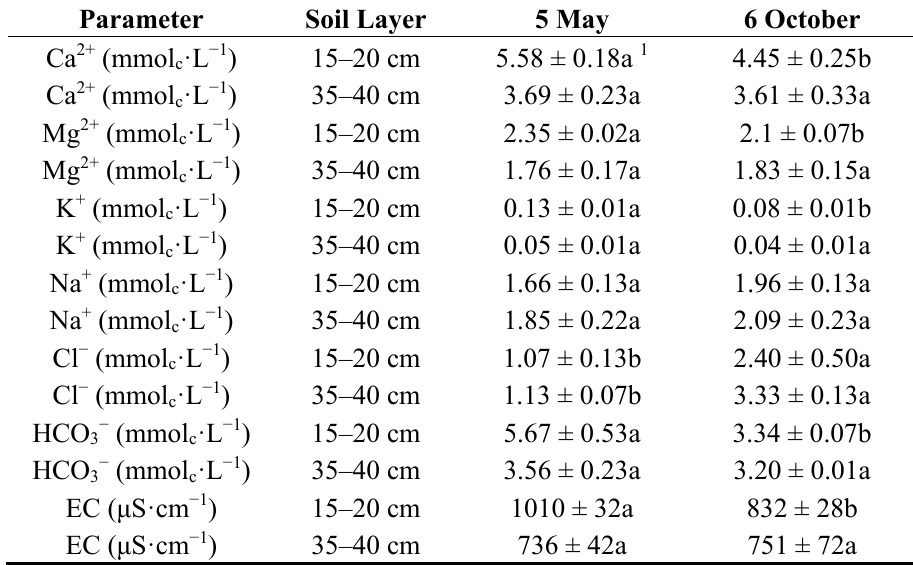
Table 2. Comparison of soluble ions Ca 2+ , Mg 2+ , K + , Na + , Cl − , HCO 3− and EC obtained from saturation extracts before (5 May) and after (6 October) the growing